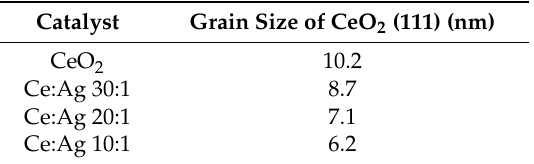
Table 1. Grain size of CeO 2 (111) plane reflection based on Scherrer’s equation. Catalyst